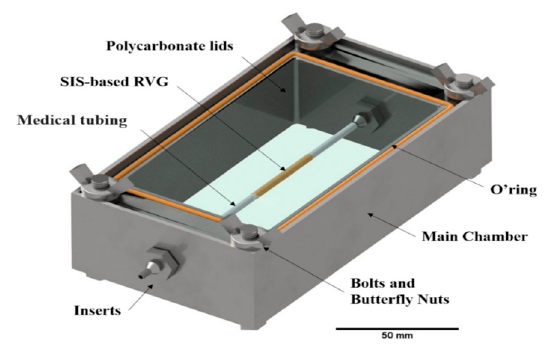
Figure 1. Fluidic device for the testing of SIS-based regenerative vascular grafts. The assembly consists of a vascular graft chamber, an infusion pump, a medium reservoir, and an agitator system.